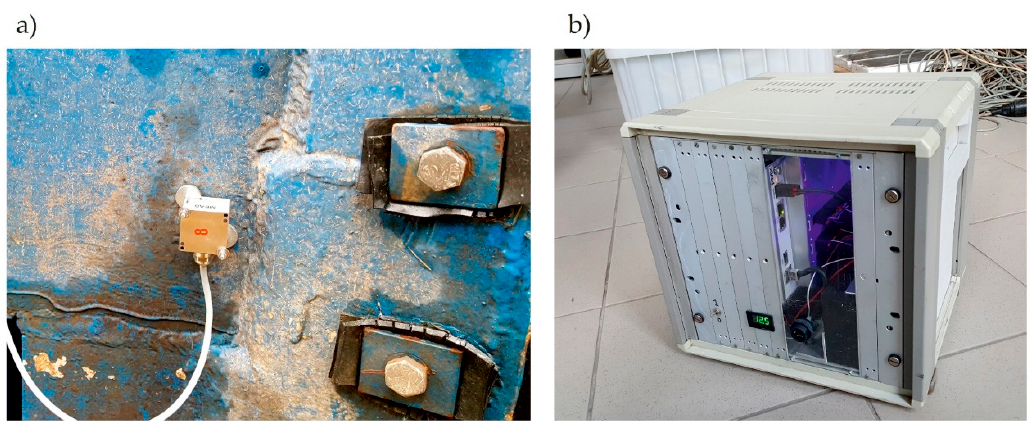
Figure 9. ( a ) Used tri-axis accelerometer TE 4332M3-002; ( b ) The individually improved HBM PMX Amplifier.